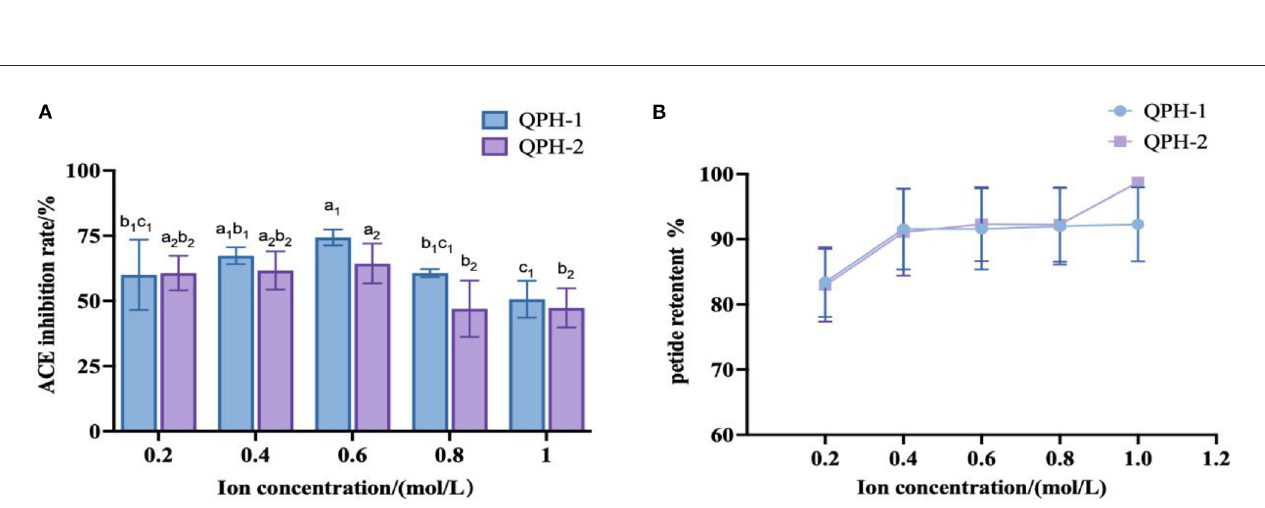
FIGURE10 (A) ACE inhibition of samples treated with different ion concentrations. (B) Peptide retention of samples treated with different ion concentrations. Different letters indicates the significant differences among samples ( p -value ≤ 0.05).